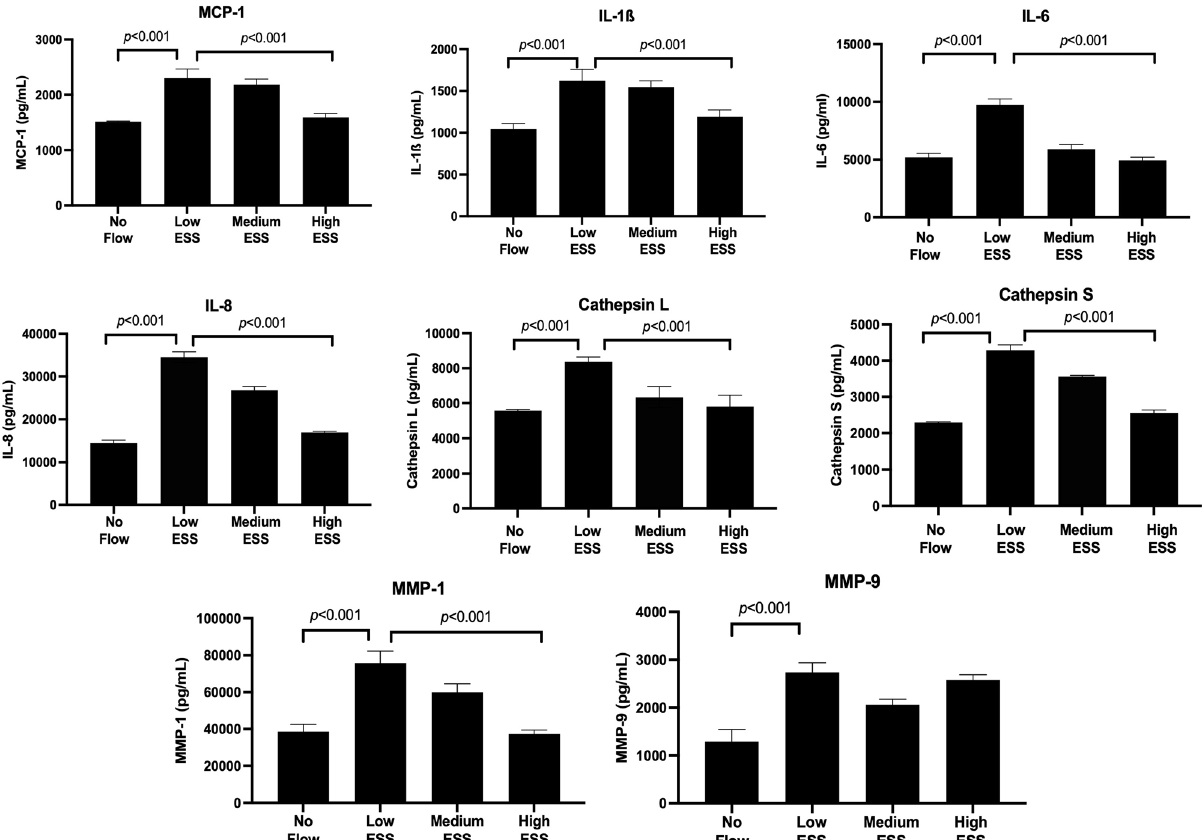
Figure 3. Effect of various shear stress conditions on the protein levels by ELISA of proinflammatory molecules and matrix-degrading enzymes in the medium of co-cultures. 3D co-culture of HCAECs, HCASMCs, and monocytes (THP-1) cells were prepared on the cover slips and exposed to low ESS, medium ESS, high ESS, or no flow (control) for 1 h followed by additional culture for 5 h. Amount of the proteins in the cell culture medium was quantified by ELISA as described in the “Methods”. IL: interleukin, ESS: endothelial shear stress, MMP: matrix metalloproteinase, MCP-1: monocyte chemoattractant protein-1, HCAECs: human coronary artery endothelial cells, HCASMCs: human coronary artery smooth muscle cells. Data were averaged over 3 separate